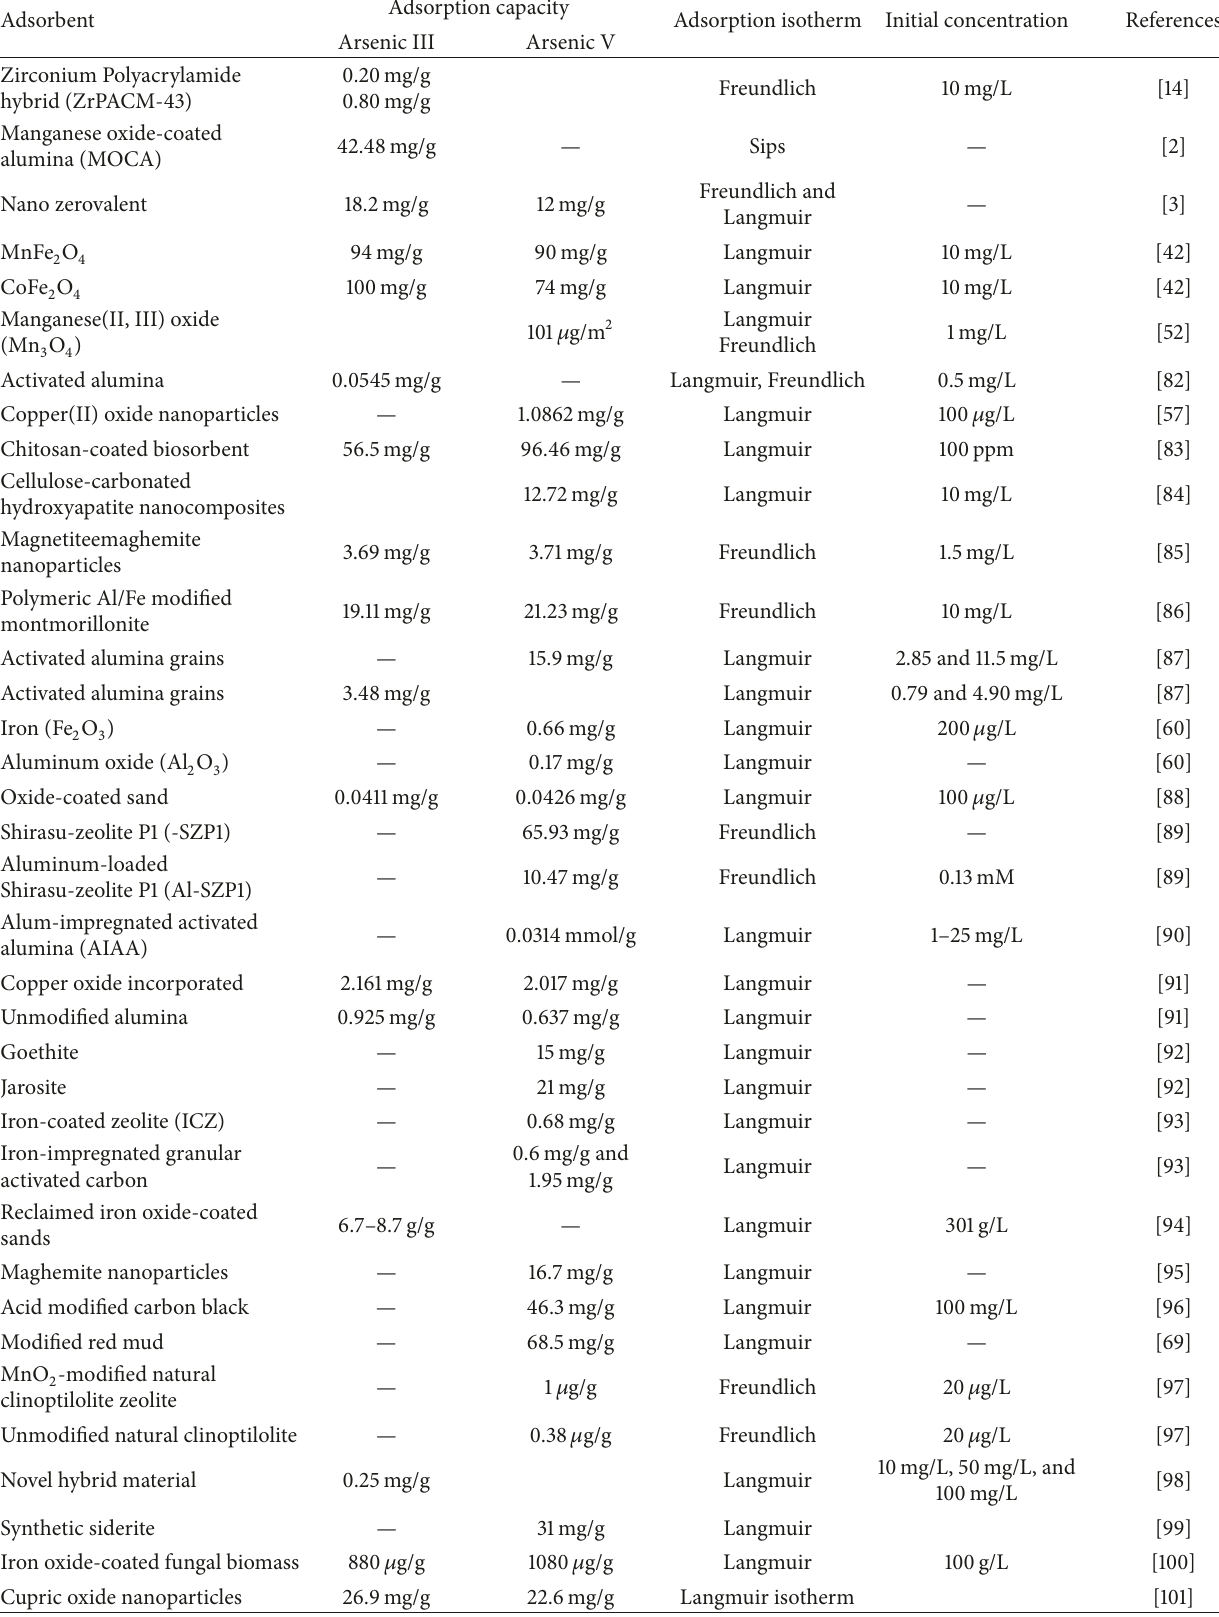
Table 1: Adsorption isotherm for